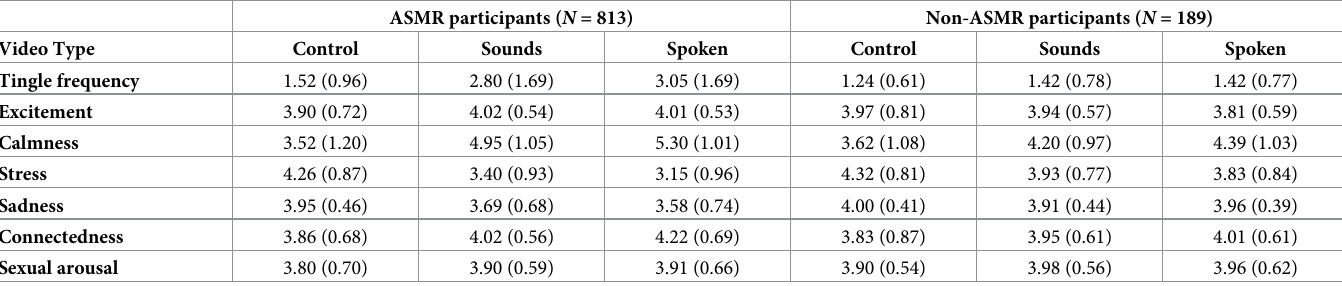
Table 2. Study 1 raw means and standard deviations for self-reported changes in affect and tingle frequency for each video type and participant group. ASMR participants ( N = 813) Non-ASMR participants ( N =